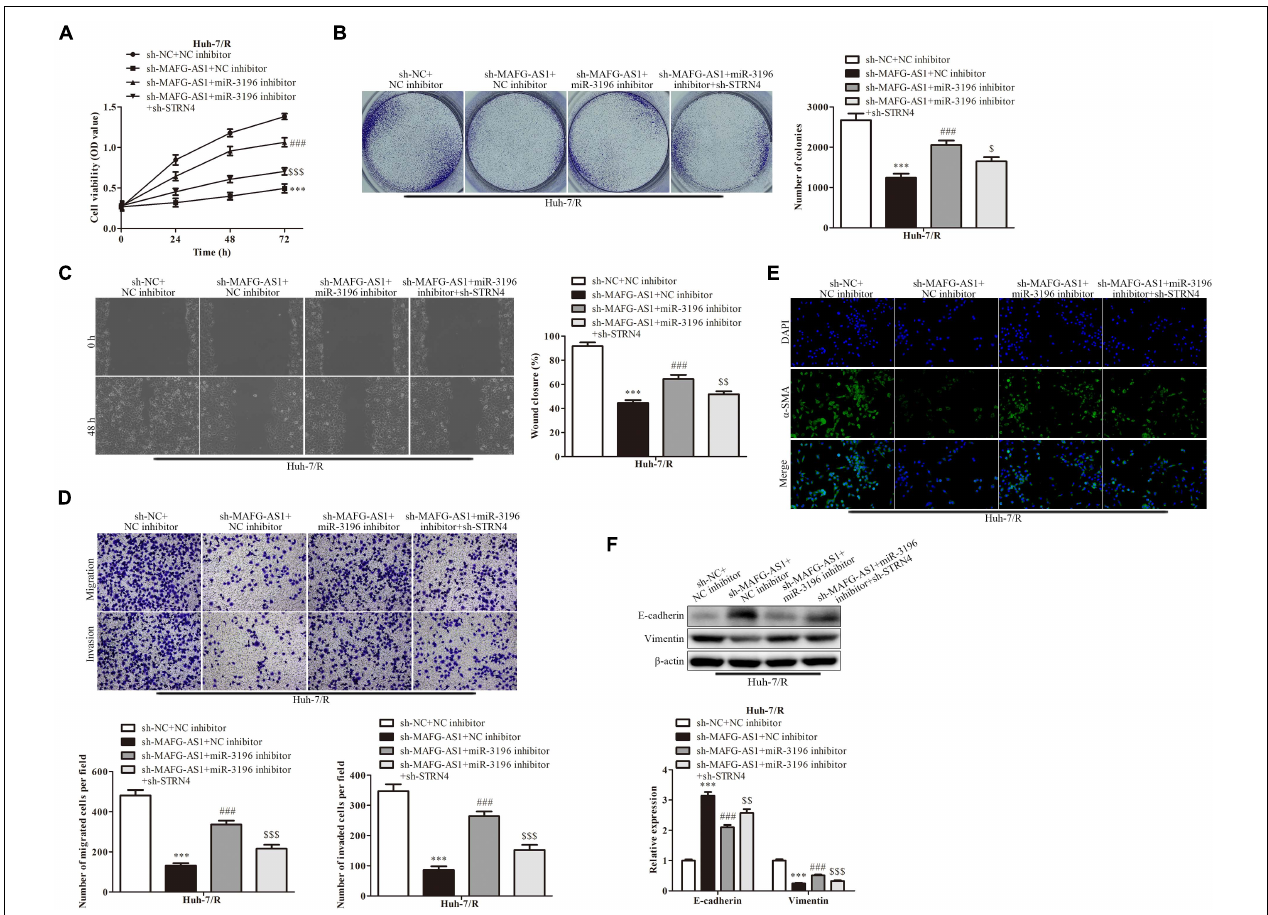
FIGURE 6 | The mechanism for MAFG-AS1 modulating STRN4 protein expression through targeting miR-3196 in liver cancer cells. (A) CCK-8 assay indicated the cell viability in Huh7/R and HepG2/R cells transfected with sh-MAFG-AS1, miR-3196 inhibitor, or sh-STRN4 compared to their negative controls. (B) The clone formation abilities of the Huh7/R and HepG2/R cells in different groups. (C) Wound healing assay (D) and transwell analysis to test the effect on the invasion and migration of HCC cells. (E) Immunostaining and (F) western blotting detected the EMT of Huh7/R and HepG2/R cells transfected with sh-MAFG-AS1, miR-3196 inhibitor, or sh-STRN4 compared to their negative controls. Scale bars: 50 µ m. *** P < 0.001 vs sh-NC + NC inhibitor group, ### P < 0.001 vs sh-MAFG-AS1 + NC inhibitor group, $ P < 0.05, $$ P < 0.01, $$$ P < 0.001 vs sh-MAFG-AS1 + miR-3196 inhibitor